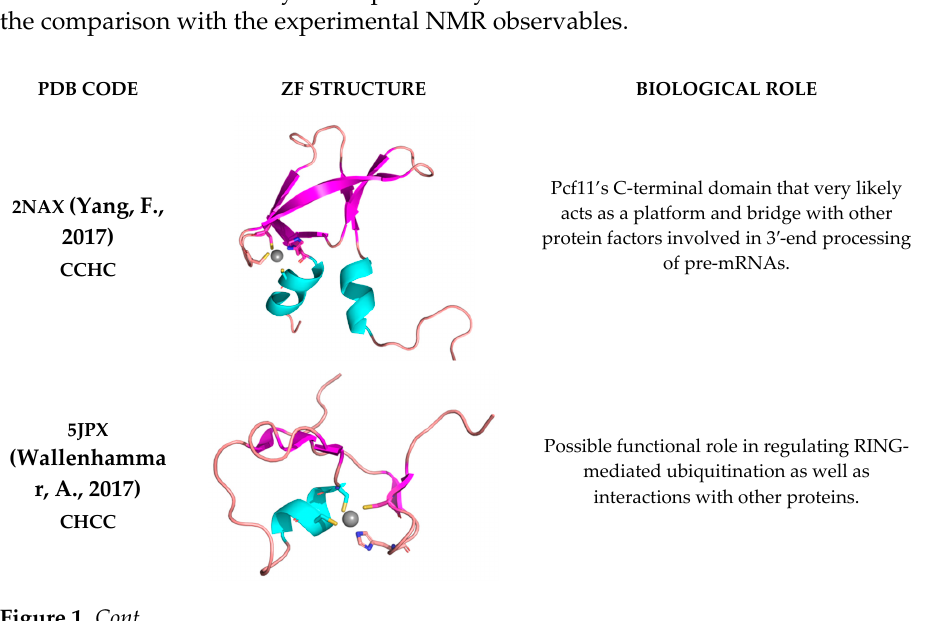
Region of the tail of the Gn glycoprotein from the crimean Congo hemorrhagic fever virus. This protein is involved in host- pathogen interaction and viral assembly. 1CHC (Barlow, P.N., 1994) CCCC CHCC Domain of E3 ubiquitin-protein ligase that probably interacts with DNA or RNA.